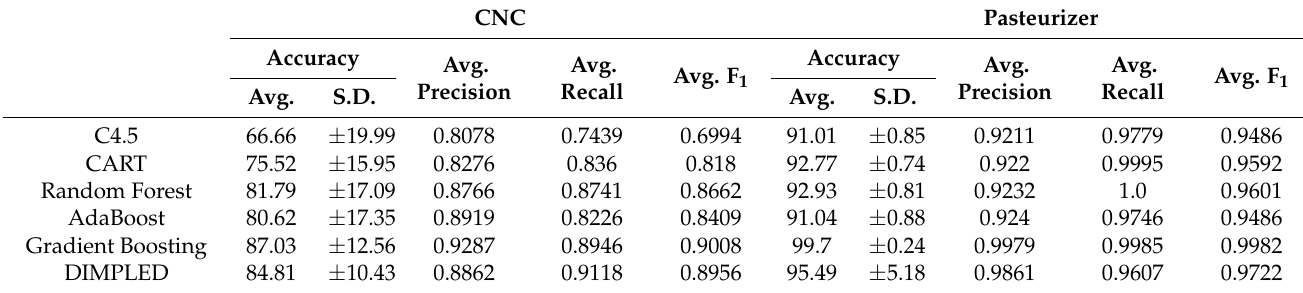
Table 6. Average test performances of DIMPLED and tree-based algorithms for CNC and Pasteurizer datasets in cross- validation.